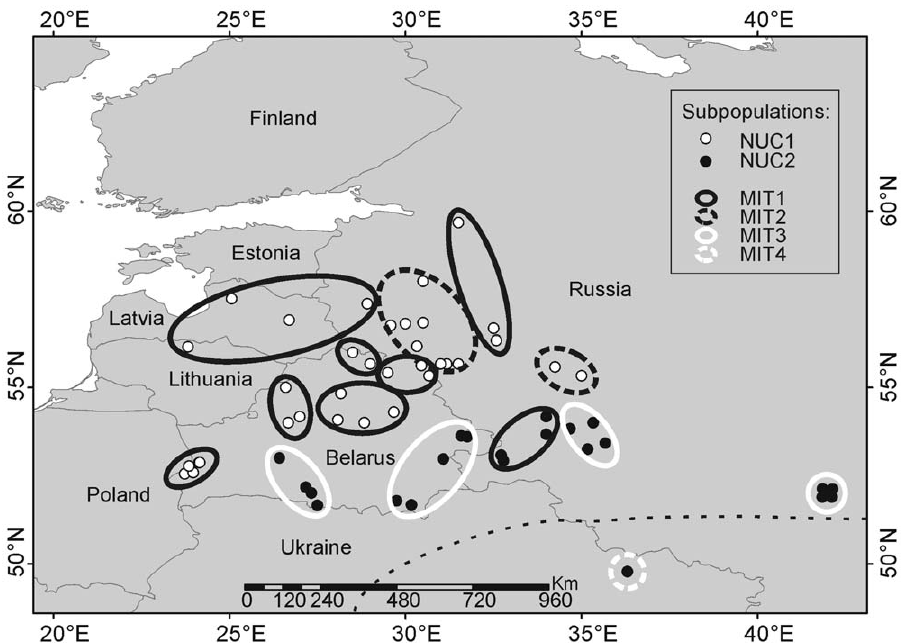
Figure 1. Geographic distribution of the grey wolf samples used in the stable isotope analysis. One point represents an individual or a group of individuals sampled in the same location, and large circles represent geographical regions the samples were grouped into. The samples were assigned to subpopulations delimited based on allele frequencies at 14 microsatellite loci (NUC 1 and NUC2), and frequencies of mtDNA haplotypes (MIT1-MIT4) based on the analysis of a larger dataset in Pilot et al. [7]. Dashed line represents the approximate border between two habitats: temperate mixed forest and forest-steppe. and d 13 C VPDB : 2 28.50 % ) and leucine ( d 15 N Air : 10.77 % and 2 31.18 % ). The international reference materials used d 13 C VPDB : for scale calibration were IAEA-CH6 ( d 13 C VPDB = 2 10.45 % , IAEA, Vienna, Austria), IAEA-600 ( d 13 C VPDB = 2 27.77 % ,